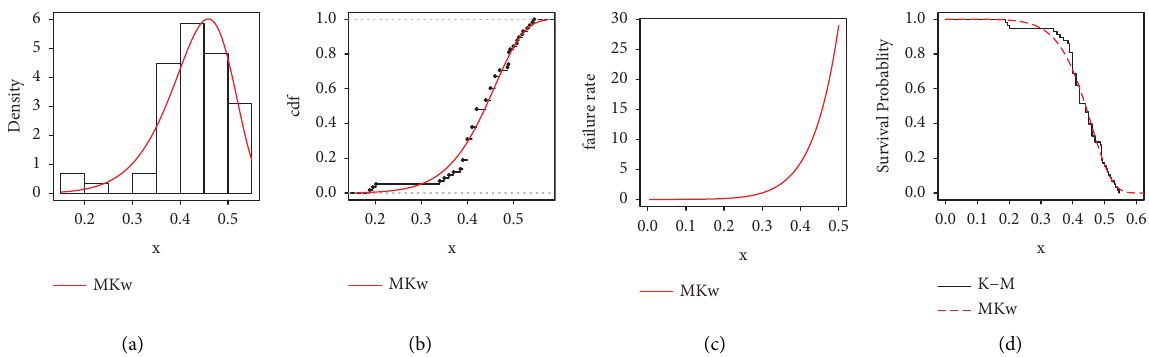
Figure 10: Plots of estimated pdf, estimated cdf, estimated hrf, and failure rate for data set 4.